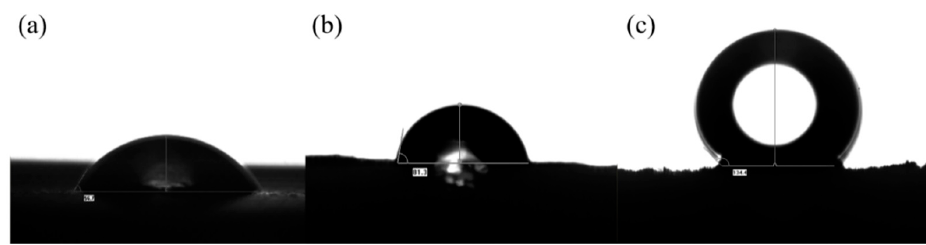
Figure 6. ( a ) Contact angle of GO; ( b ) Contact angle of GA; ( c ) Contact angle of PDMS/GA.